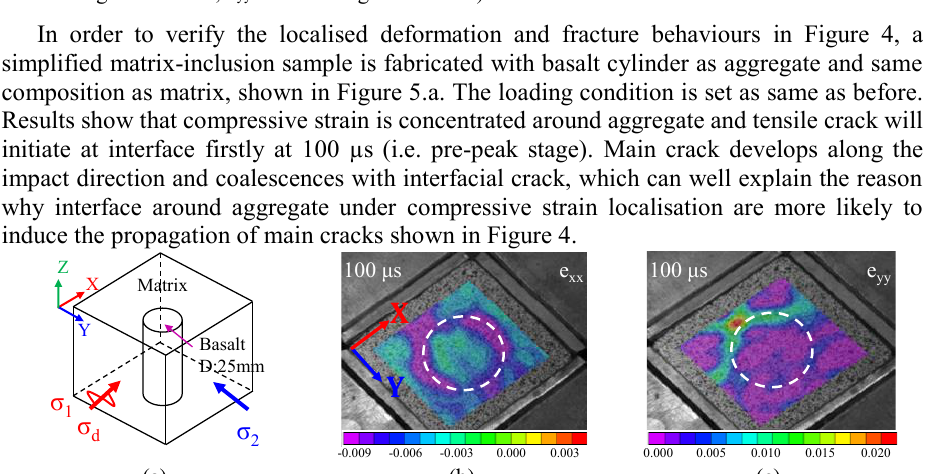
Fig. 4. (a) Dynamic stress-strain curve, and (b) synchronized strain fields obtained by 3D-DIC (e xx : strain along X direction; e yy : strain along Y direction).